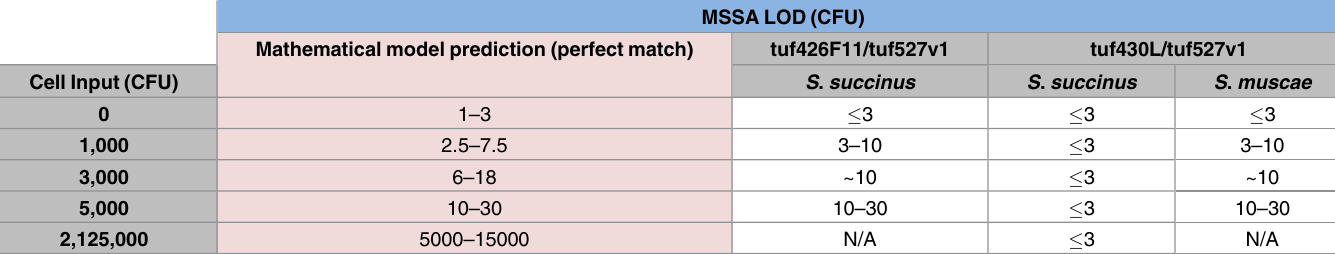
Table 2. MSSA limit of detection with different primer pairs and different suppressor cell inputs.